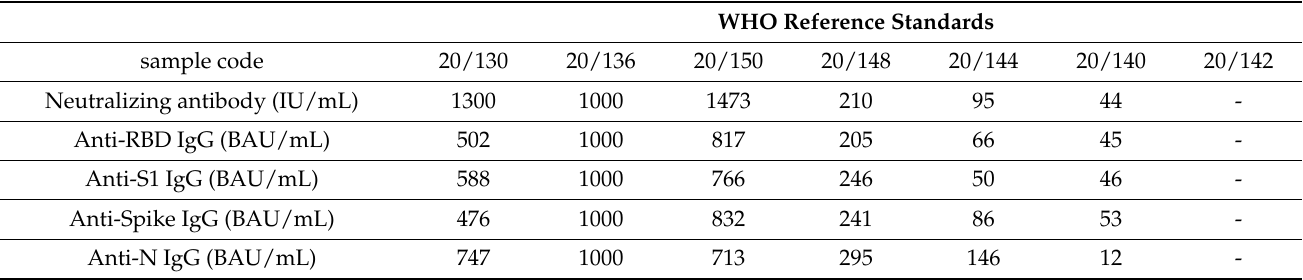
Table 1. WHO international reference standards for anti-SARS-CoV-2 immunoglobulin and neutraliz- ing